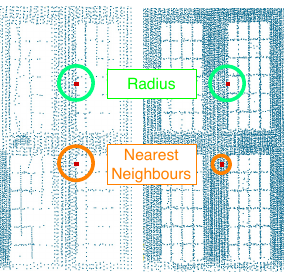
Figure 3. KNN vs. Radius-based neighborhood